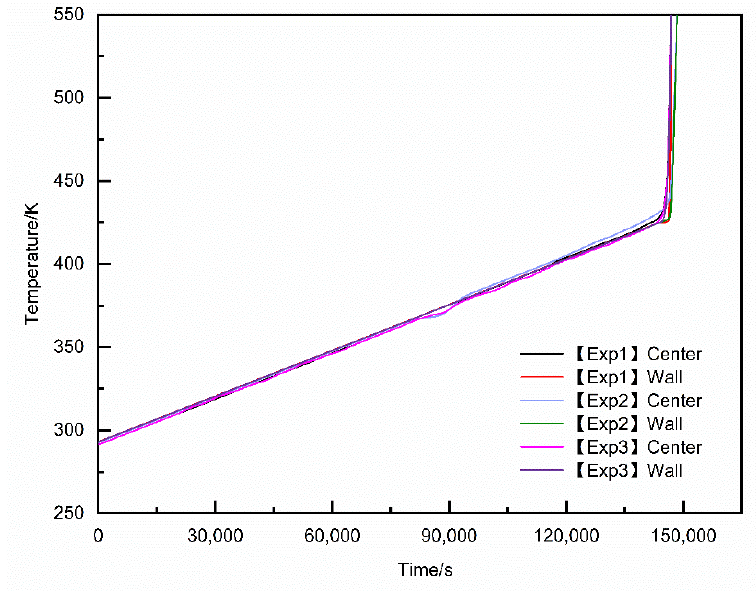
Figure 6. Temperature-time curve of sample experiment.